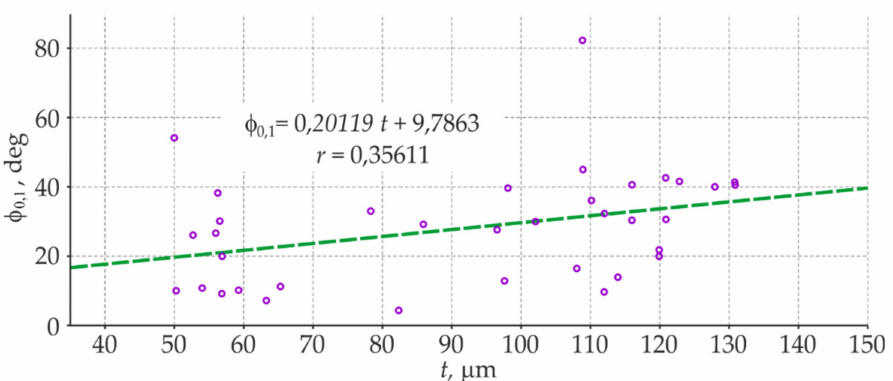
Figure 14. Correlation relationships between the thickness t of the blue coating and angles of the phase shift ϕ 0.1 at 36 test